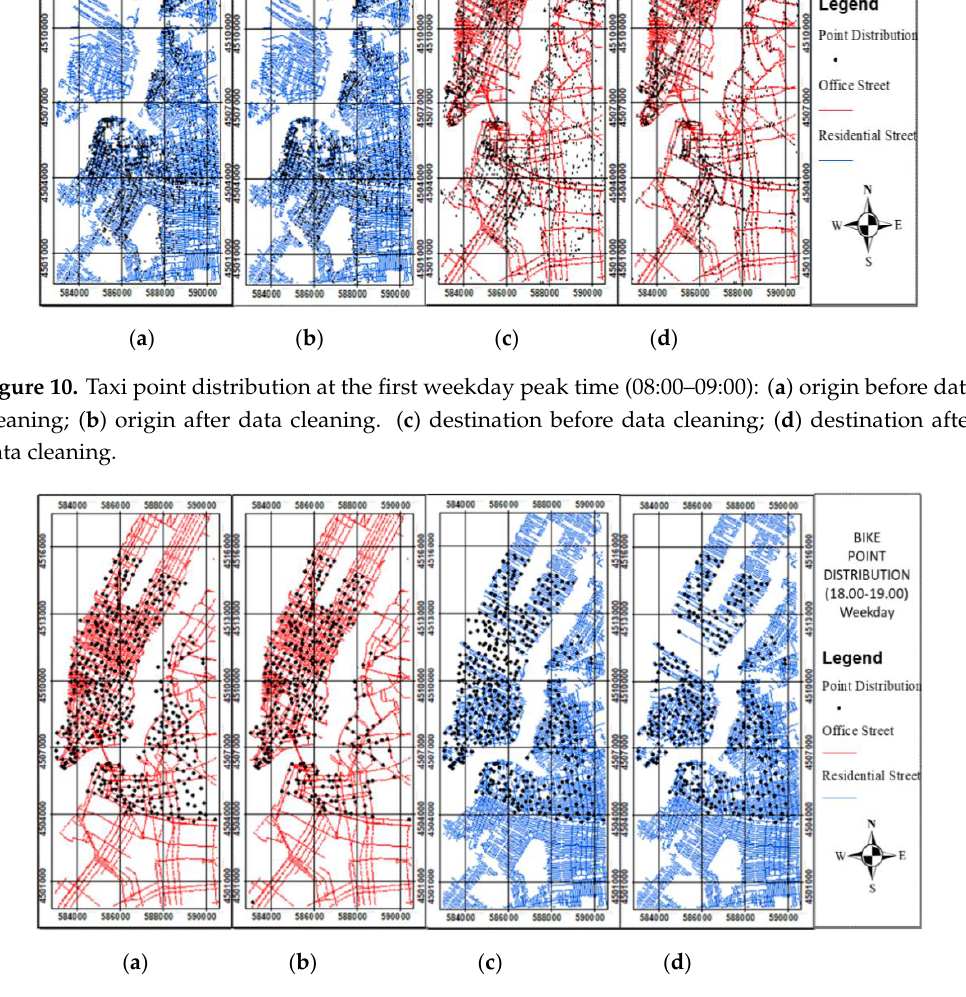
Figure 11. Bike point distribution at the second weekday peak time (18:00 – 19:00): ( a ) origin before data cleaning; ( b ) origin after data cleaning. ( c ) destination before data cleaning; ( d ) destination after data cleaning.